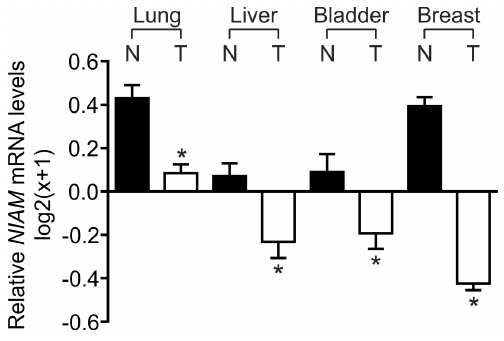
Figure 1. NIAM mRNA expression is downregulated in multiple human cancers. NIAM mRNA levels are significantly reduced in primary tumor (T) samples relative to normal (N) tissue, according to RNA-seq data obtained from the TCGA project database. The number of samples analyzed for each tissue was as follows: lung (N=58, T=488), liver (N=50, T=147), bladder (N=19, T=211), and breast (N=108, T=992). Error bars represent a 95% CI as calculated using the standard error, and an unpaired Welch’s T-test was used to calculate statistical significance (*, p , 0.0001).